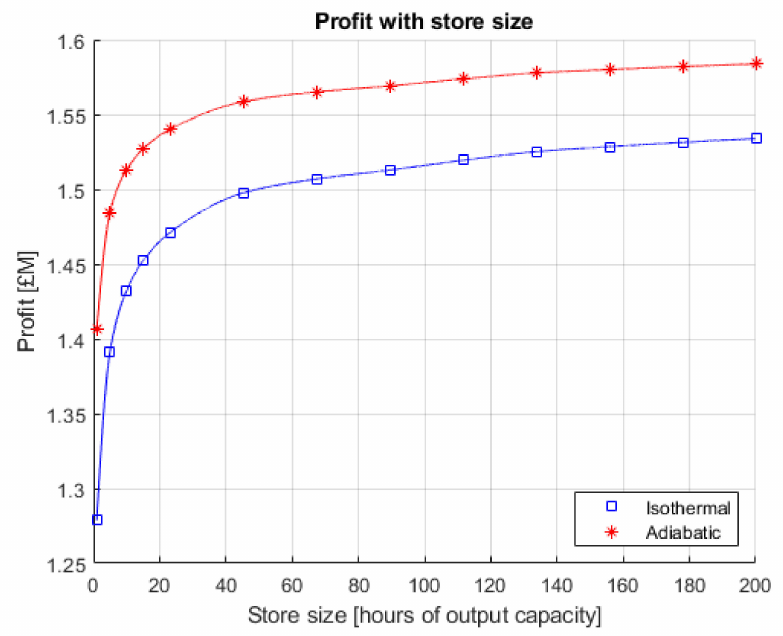
Figure 15. The relationship between profit and storage capacity for a representative system with the maximum allowable inlet swept volume.